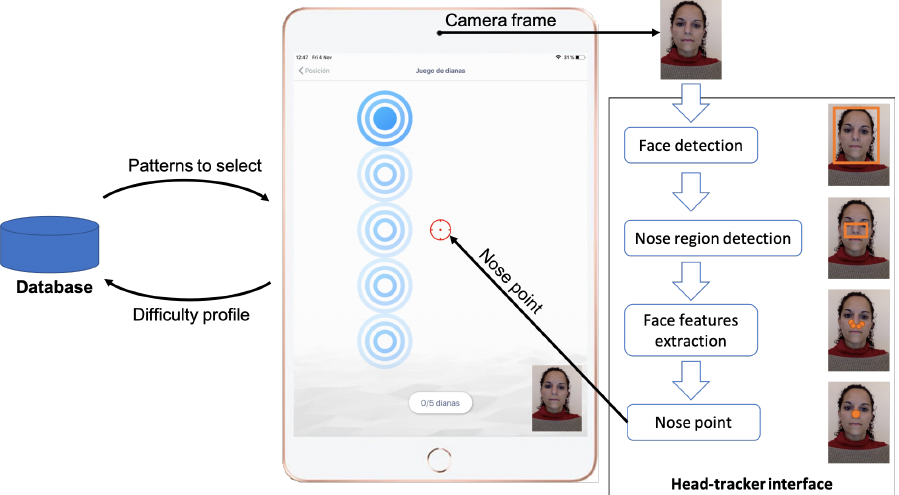
Figure 3. Architecture of the exergame. After selecting a difficulty profile, the mobile application sequentially presents a set of patterns of targets to select with the cursor (gun sight). The head-tracker interface captures a camera frame and returns the position of the nose of the user, which is translated in the position of the cursor through the transfer function described in Section 2.